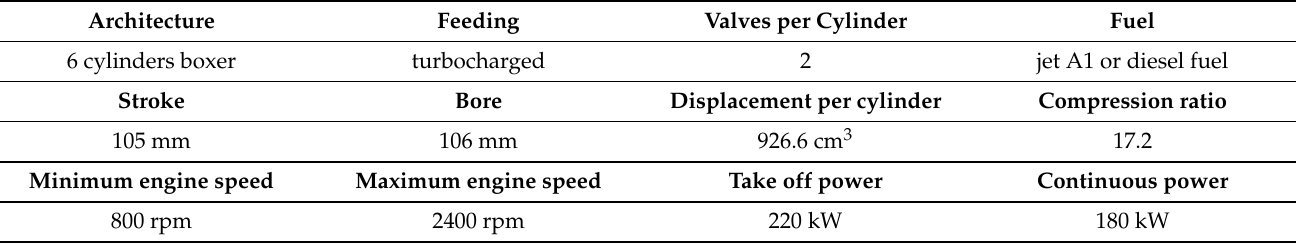
Table 1. Specifications of GF56